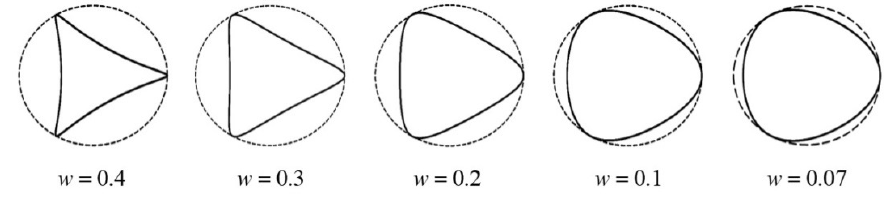
Figure 4. Configuration of approximately triangular holes with different shape factors.